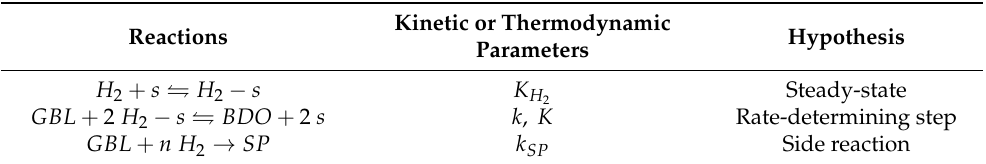
Table 3. Reaction mechanism used for the construction of the kinetic model with inhibition of hydrogen partial pressure: Model